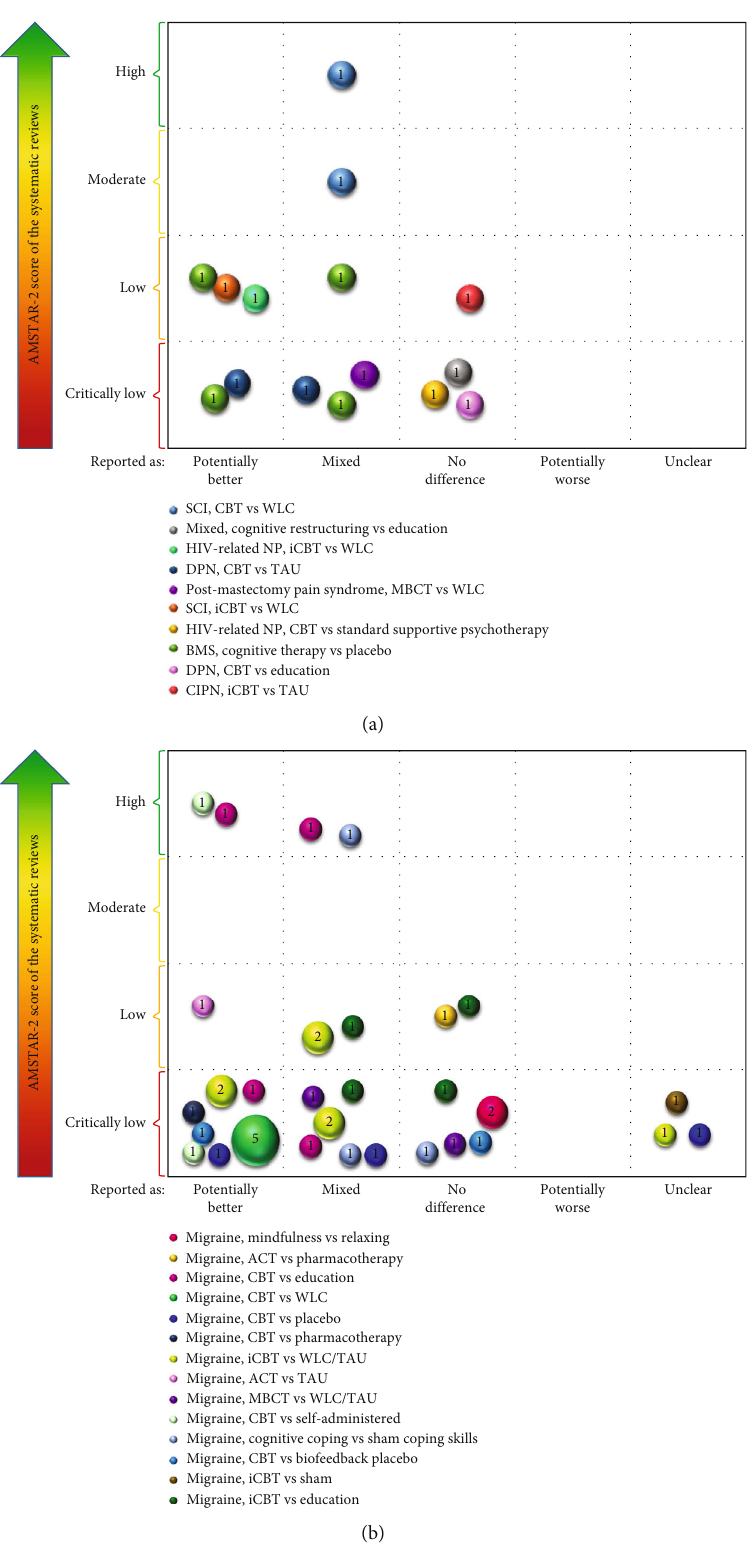
Figure 4: (a) Evidence mapping of the CBT for NP (excluding migraine). (b) Evidence mapping of CBT for migraine. SCI: spinal cord injury; WLC: waiting list control; BMS: burning mouth syndrome; TAU: treatment as usual; iCBT: Internet-based CBT; iACT: Internet- based ACT; DPN: diabetic peripheral neuropathy; CIPN: chemotherapy-induced peripheral